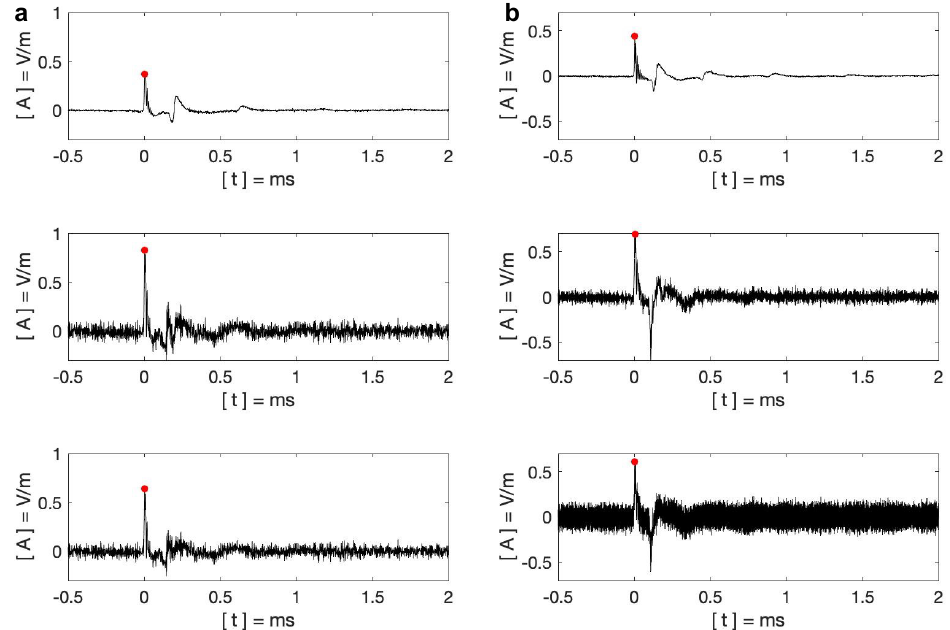
Figure 13. ( a ) Amplitude waveforms used in the simulation with a small network ( N = 10). ( b ) Amplitude waveforms used in the simulation with a small network ( N = 20). For both figures ( a , b ), the upper figures are the averaged waveforms from the amplitude waveform bank (270 km and 410 km); the middle figures are the scaled amplitude waveforms; and the bottom figures are the ratioed amplitude waveforms. In all the figures, the ground wave maxima are marked with red dots.